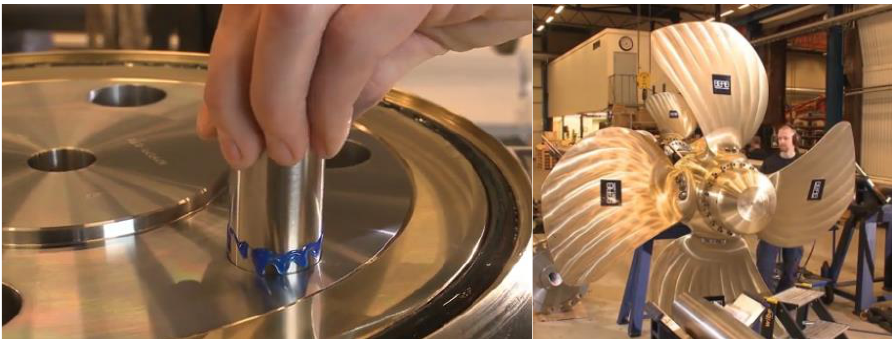
Figure 1. Typical application of anaerobic adhesives in propeller blades (securing dowel pins in propeller blades and thread lockers).